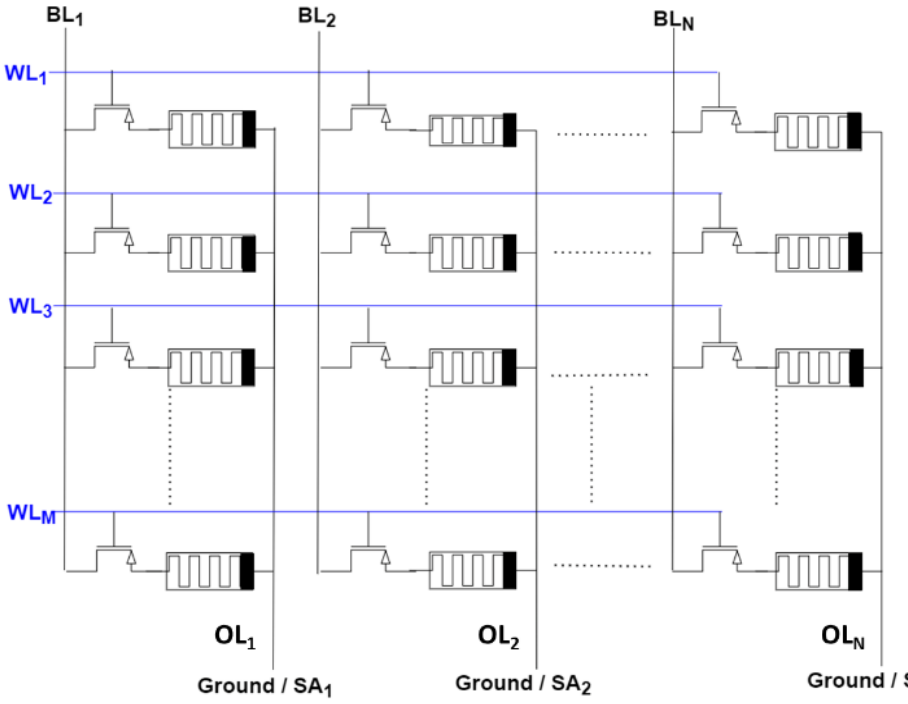
Figure 2. Circuit schematic of a 1T1R crossbar array. WL i denotes wordlines, whereas BL i denotes bitlines. The bottom electrodes (BE) of memristors (denoted by the black thick line) in every column output line (OL) connect to a sense amplifier, SA i , or to ground. (Different color is used for crossing WL and OL lines that are not